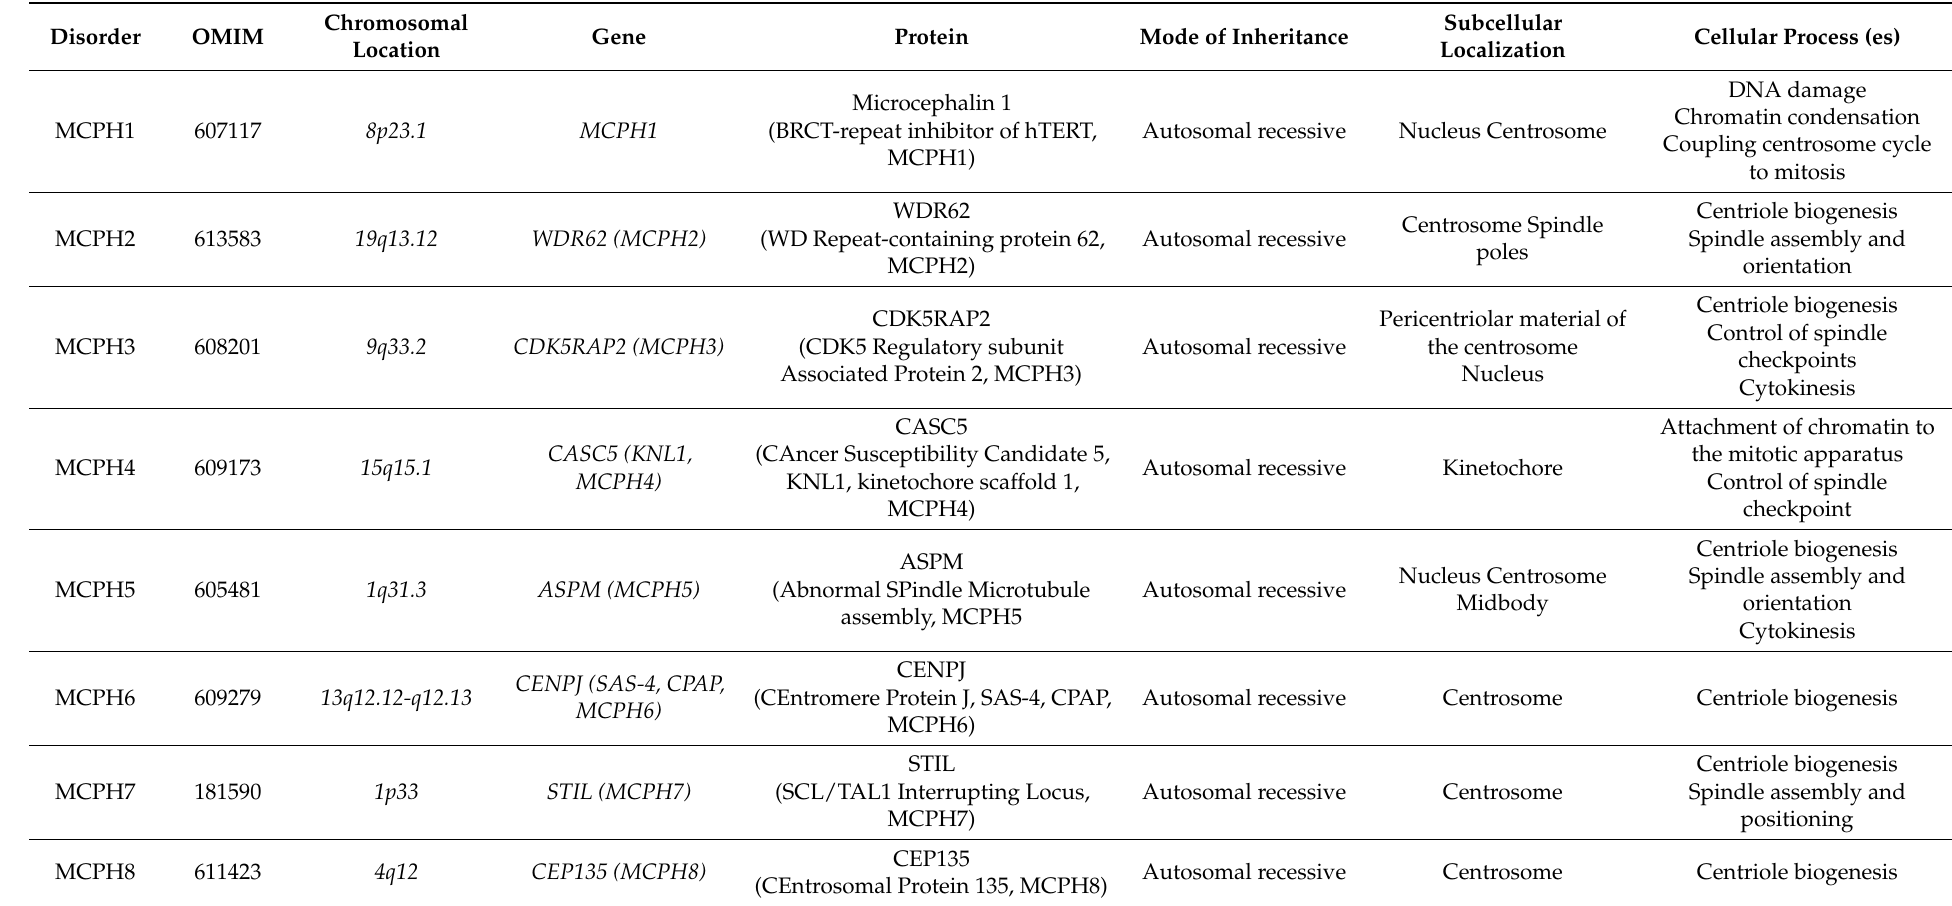
Table 1. MCPH genes (February